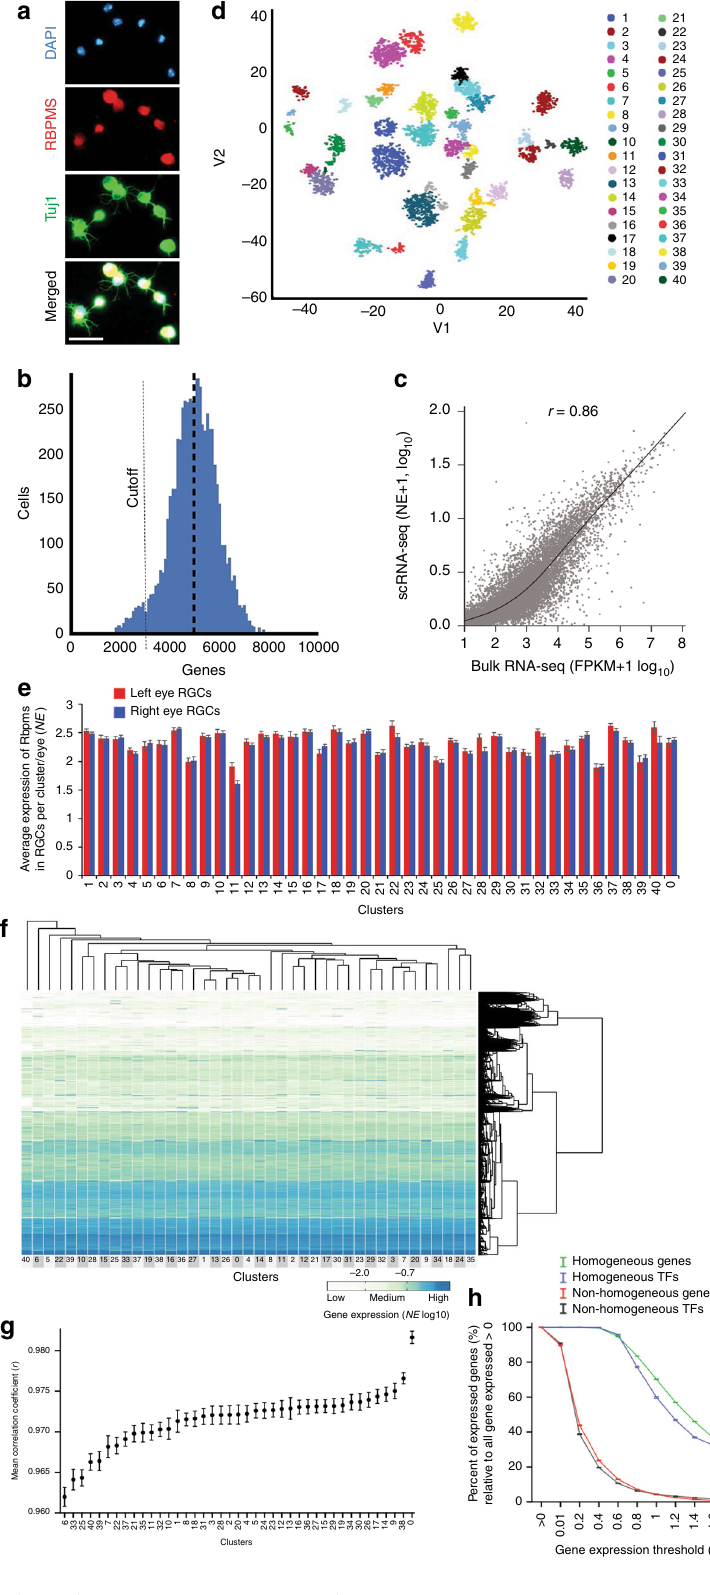
Homogeneous genes genesHomogeneous TFs Non-homogeneous Non-homogeneous TFs Gene expression ( NE